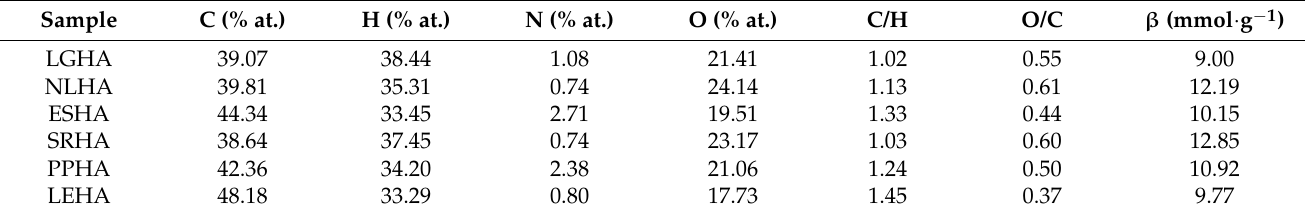
Table 1. Elemental composition and total acidity ( β ) of studied humic acids (normalized on dry ash-free samples)